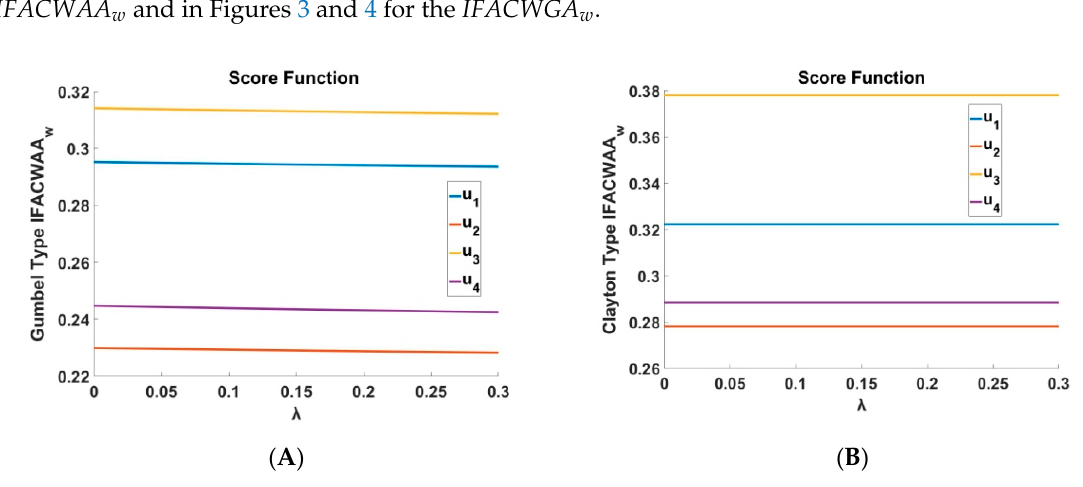
Figure 1. ( A ) Gumbel-type IFACWAA w score result. ( B ) Clayton-type IFACWAA w score result.